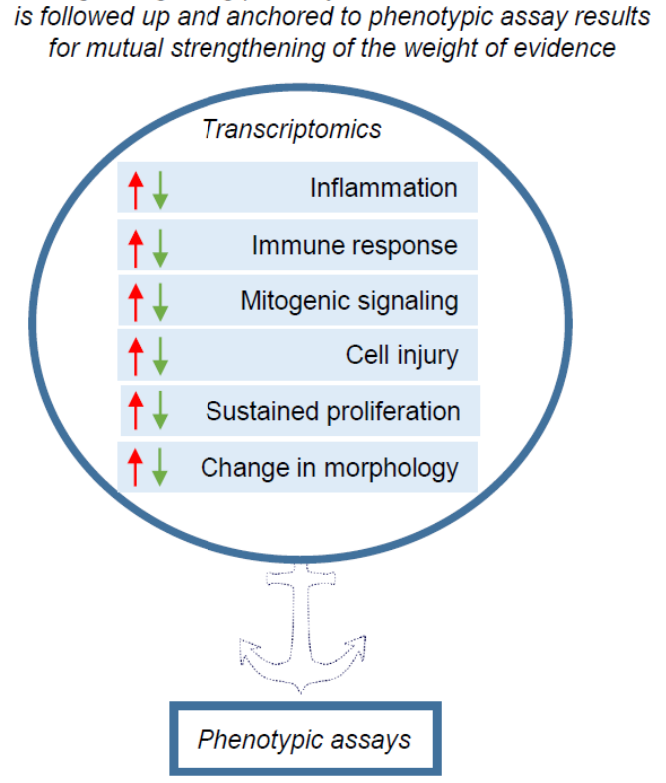
Figure 1. An overview scheme of transcriptomics application for pre-screening the possible pheno- typic changes leading to carcinogenesis in the NGTxC IATA. The signalling pathways associated with biological processes for MIE and KEs (boxes with arrow heads reflecting down/up regulation of gene expression) encircled in blue, may be screened by transcriptomic tools. Transcriptomics captures the signalling pathways and ‘flags’ the possible changes in biological processes that can be picked up in more complex in vitro and in vivo assays, particularly with respect to the KE of uncontrolled proliferation for example. The next step is that the phenotypic assays within each KE block/mode of action can further target and delineate the changes in the carcinogenic phenotypes, induced by chemicals.